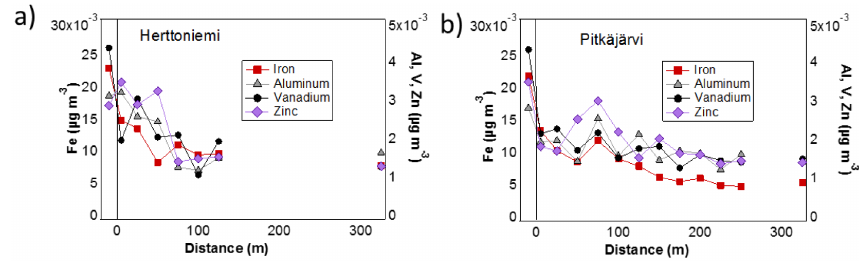
Figure 8. Concentrations of iron, aluminum, vanadium, and zinc at Herttoniemi (a) and Pitkäjärvi (b) as a function of distance from the highway. Zero distance refers to the roadside, negative values to driving on the highway and the right-most point to the background location. Background values are not subtracted from the measured concentrations. Gradients for Itä-Pakila and Malmi are presented in the Supplement. Concentrations of metals were calculated by using the RIEs given in Carbone et al.